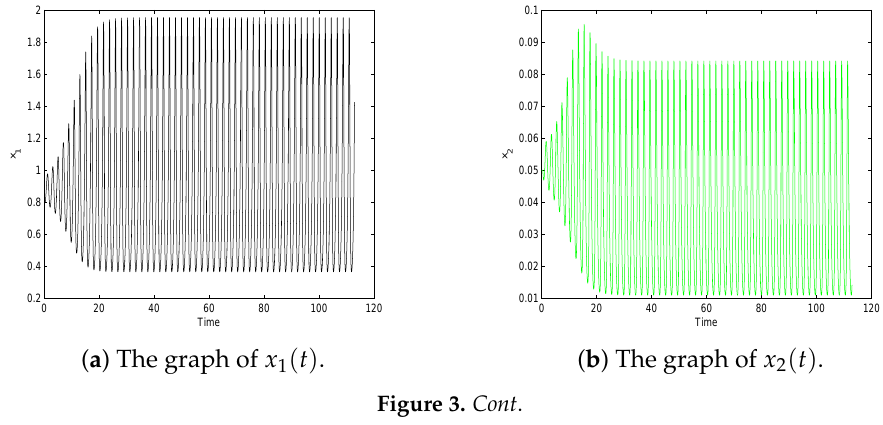
Figure 2. Behavior of system (6) with τ = 0.4. The positive equilibrium E is asymptotically stable when ≈ 0.4414. τ < τ + 0